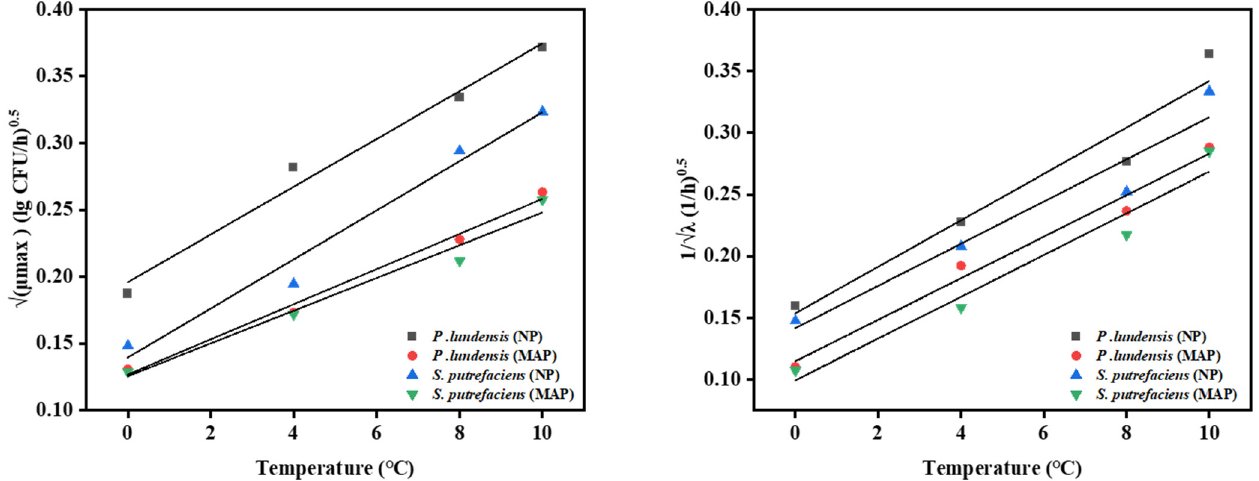
Figure 5. Maximum specific growth rates obtained and lag phase durations from the modified Gompertz model fitted to Ratkowsky.